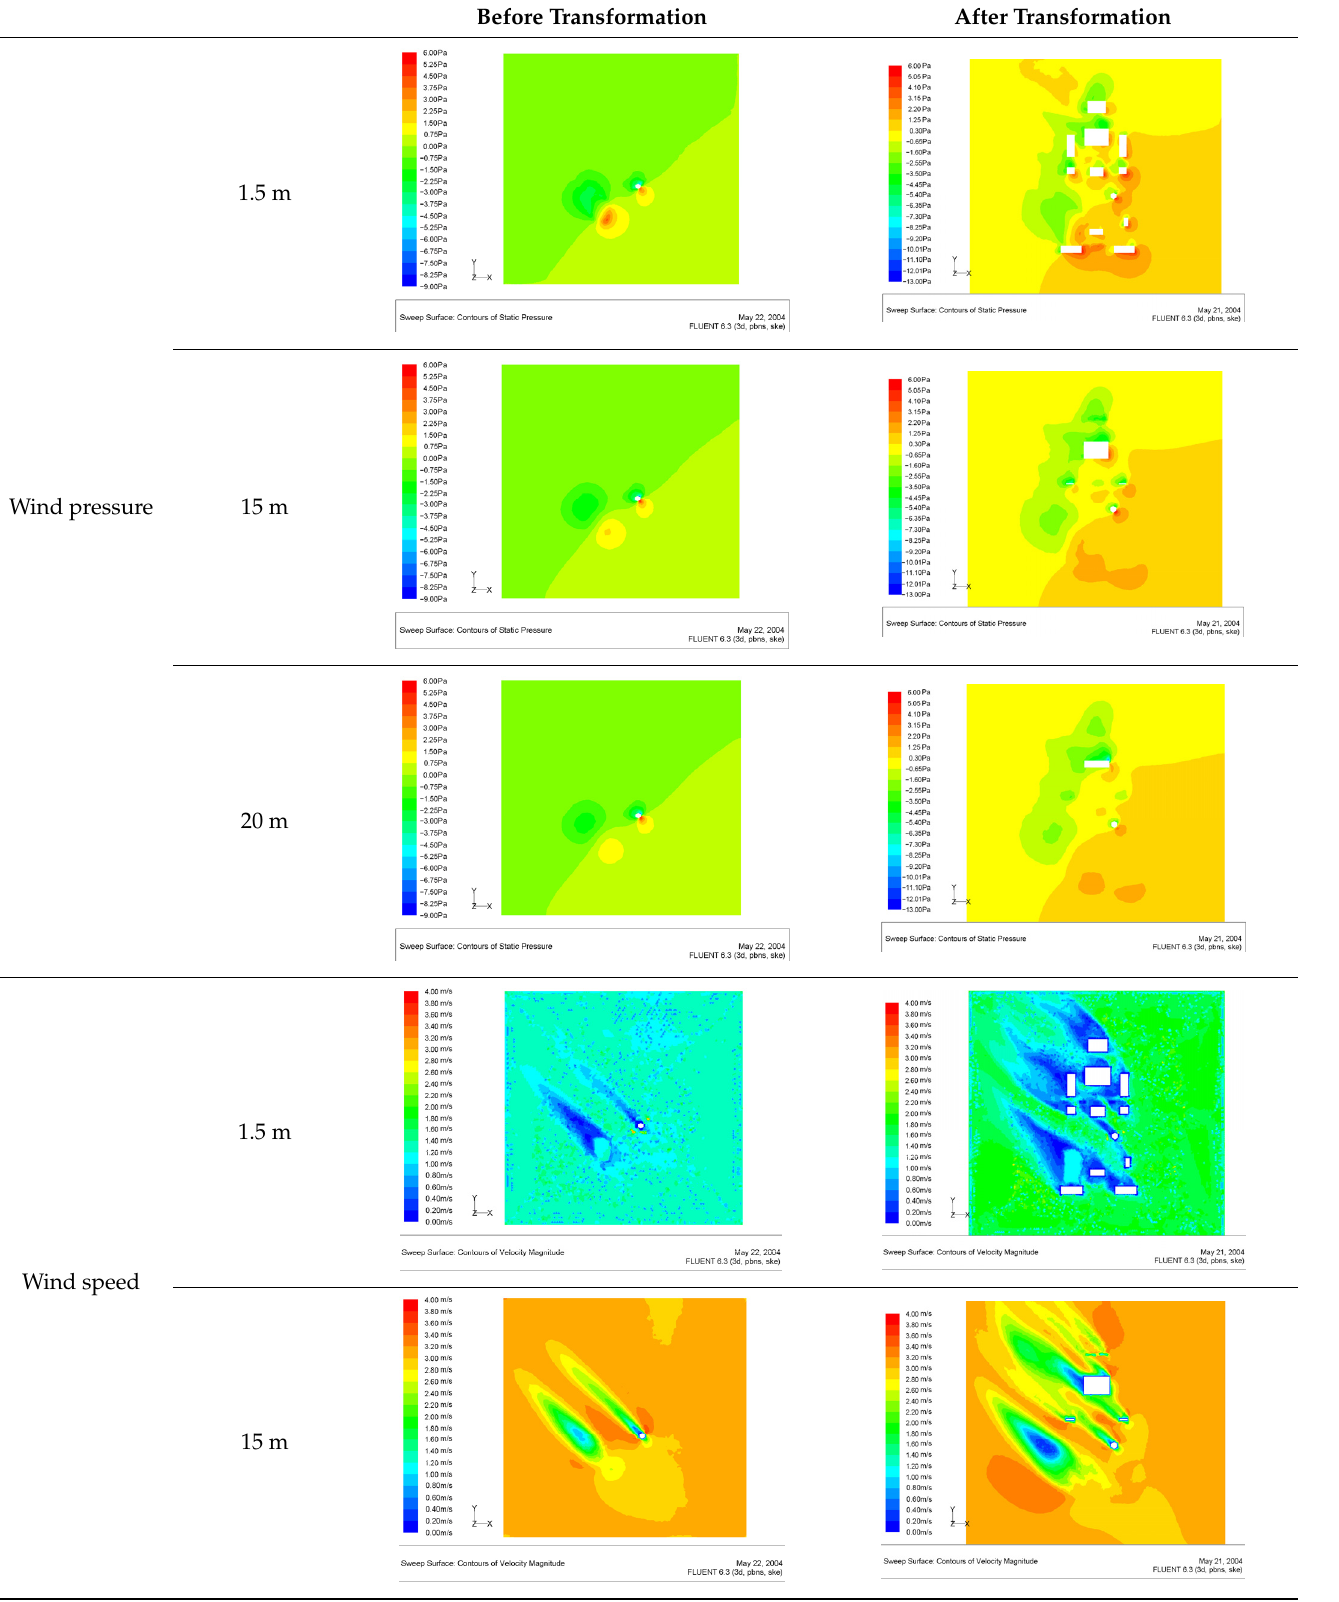
Table 1. Height of the wind pressure, wind speed and wind direction (1.5 m, 15 m, 20 m) before and after the planned transformation.